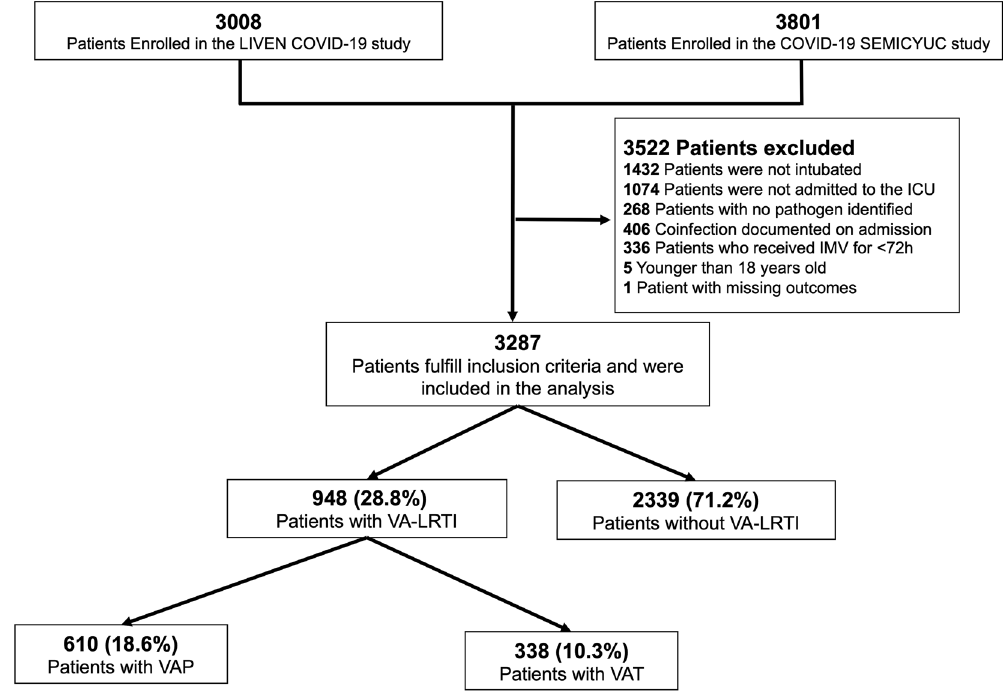
Figure 1. Flow chart of patients included in the